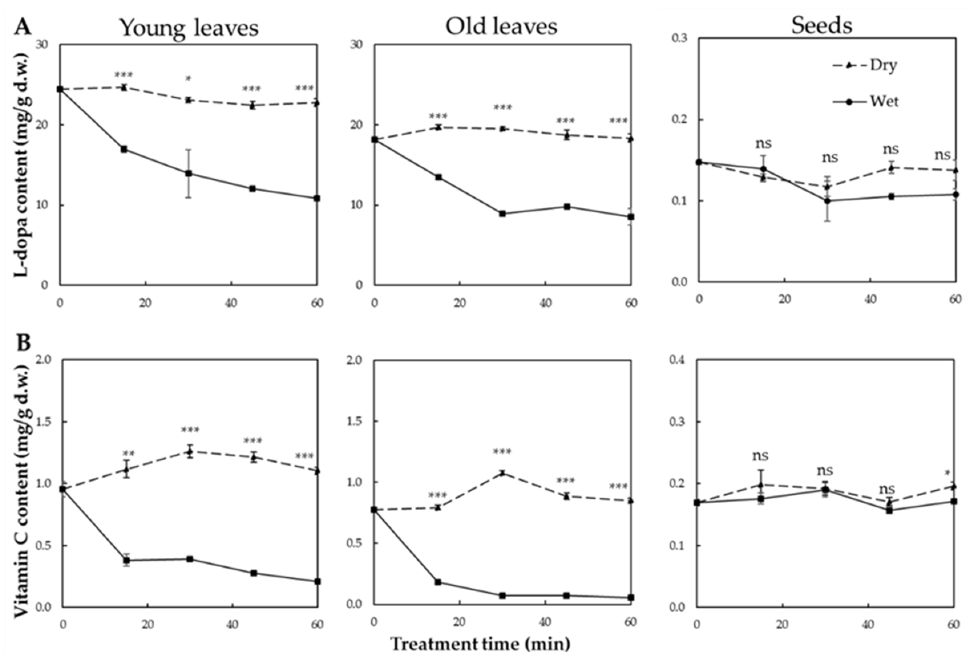
Figure 3. Changes in L-dopa ( A ) and Vitamin C; ( B ) contents after dry and wet heat treatments of young and old faba leaves and faba seeds for different treatment times. Values marked with asterisks are significantly different between the dry and wet heat treatments. (Tukey’s HSD test: * indicates p < 0.05, ** indicates p < 0.01, *** indicates p < 0.001 and ns indicates no significance).